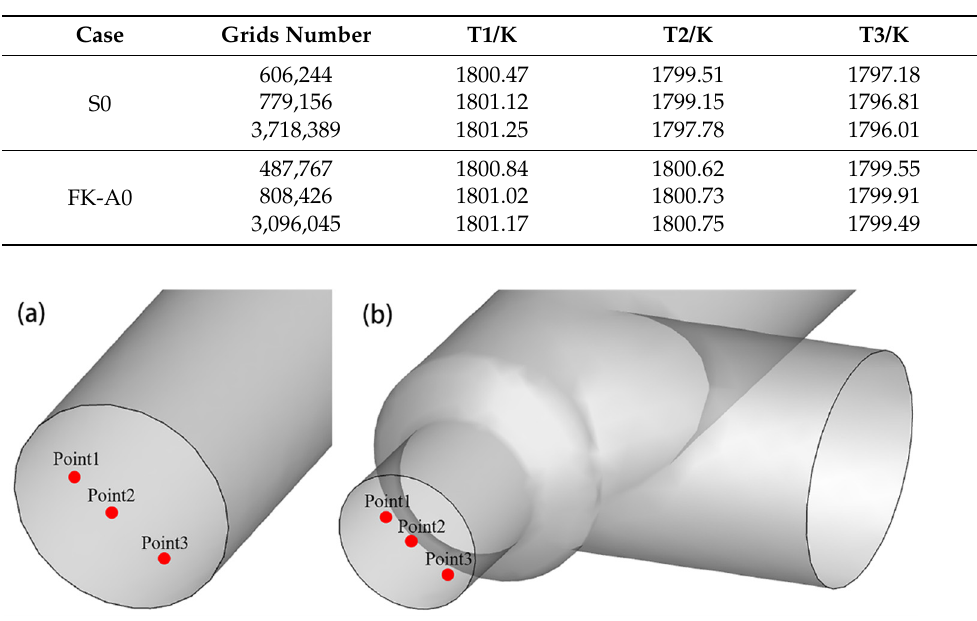
Table 4. Temperature of reference points with different grid numbers.